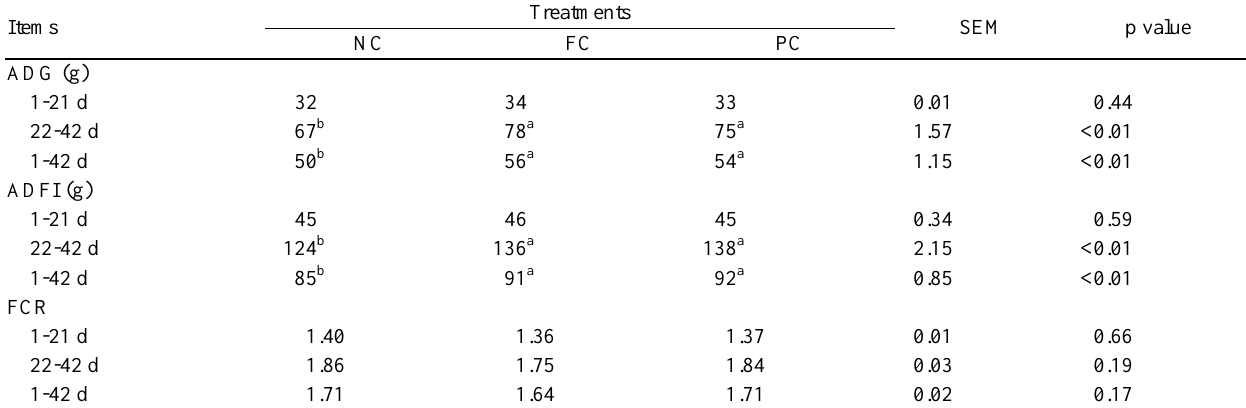
Table 3. Effects of dietary FSE and chlortetracycline supplement on the growth performance in broilers Items